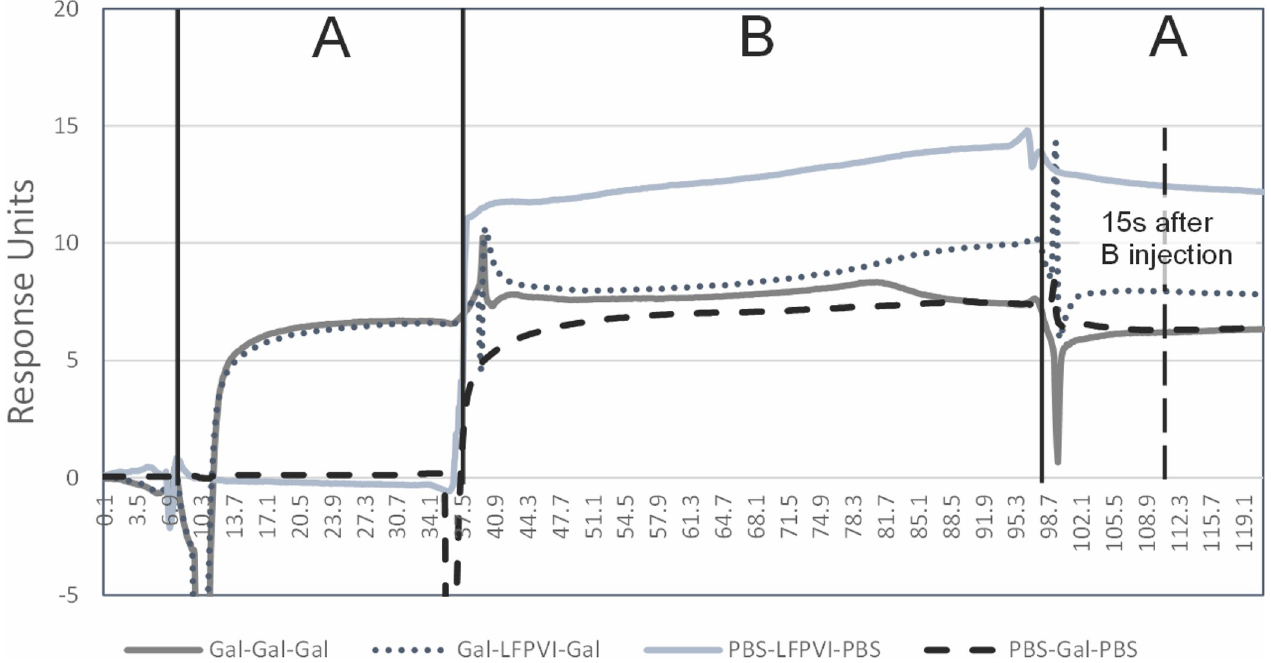
Fig 7. Competition between galactose and lacto-N-fucopentose VI binding to UclD. Injections are indicated as injection-A (PBS or galactose at 1 mM for 30 seconds) and injection-B (galactose at 1 mM or lacto-N-fucopentose VI at 50 μ M for 60 seconds). Final responses units (RU) of injections are recorded (indicated by dashed vertical line and label), with the response of galactose equalling 6.3RU ± 0.15 at 15 seconds after injection-B and lacto-N-fucopentose VI equalling 12.4 RU ± 0.41 at 15 seconds after injection-B. The response 15 seconds after injection-B when galactose and lacto-N-fucopentose VI were competed was 7.9 RU ± 0.3. As this value sits between 6.3 and 12.4 RU, it indicates direct competition for the same site with lacto-N-fucopentose VI replacing some of the bound galactose during the 60 second injection-B.